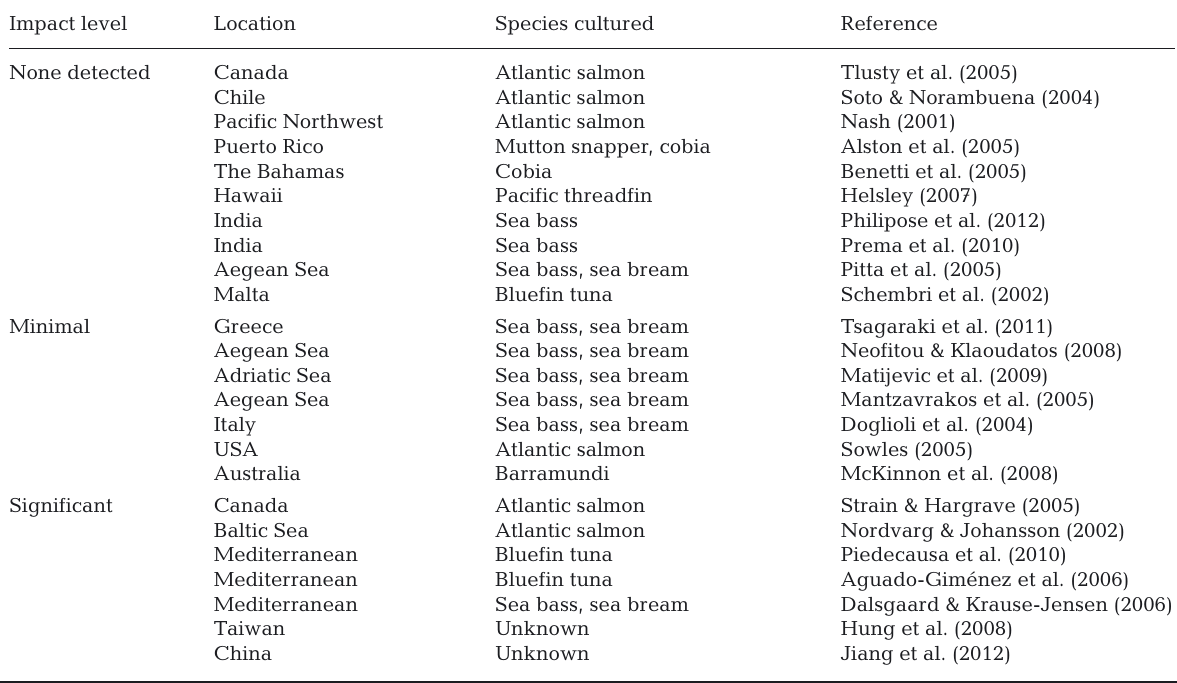
Table 4. Levels of dissolved phosphorus discharge reported and modeled at fish cage sites. At sites with minimal impact levels, the authors reported measurable increases in dissolved phosphorus, but these were statistically insignificant or were